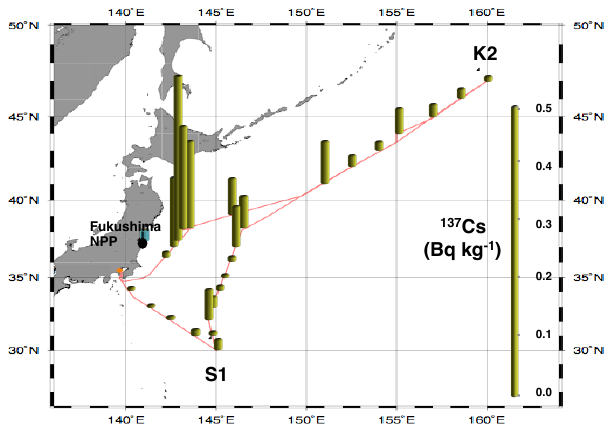
Fig. 1 (Honda et al) Fig. 1. Sediment trap location. Background is horizontal distribu- tion of 137 Cs concentration in surface seawater along R/V Mirai MR11-02 cruise track in April 2011 (Honda et al.,